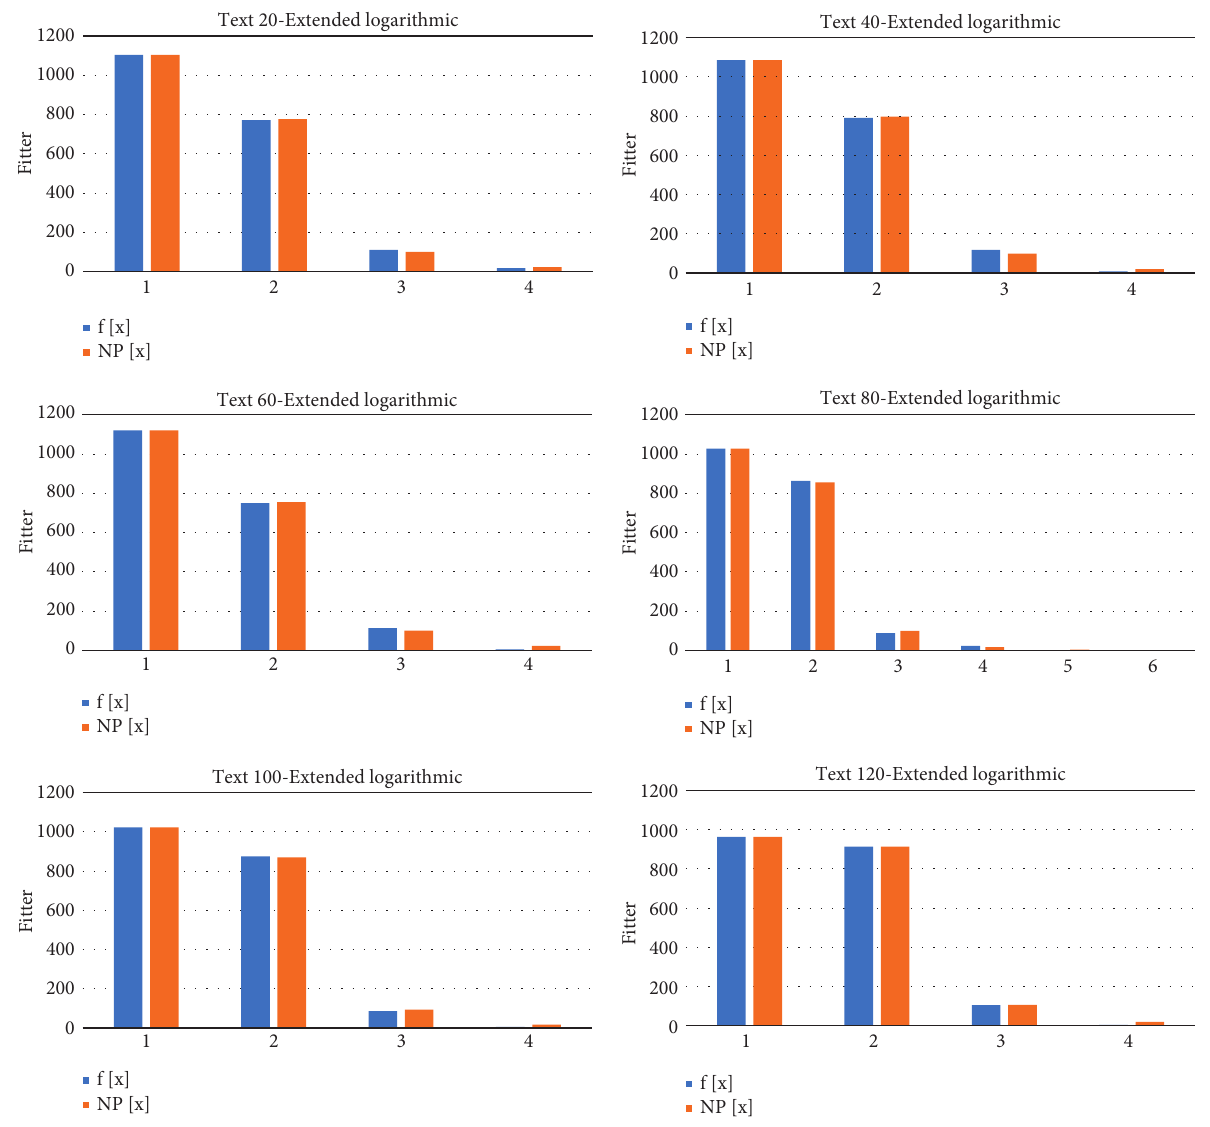
Figure 1: Fitting of extended logarithmic to word-length distribution in six sample